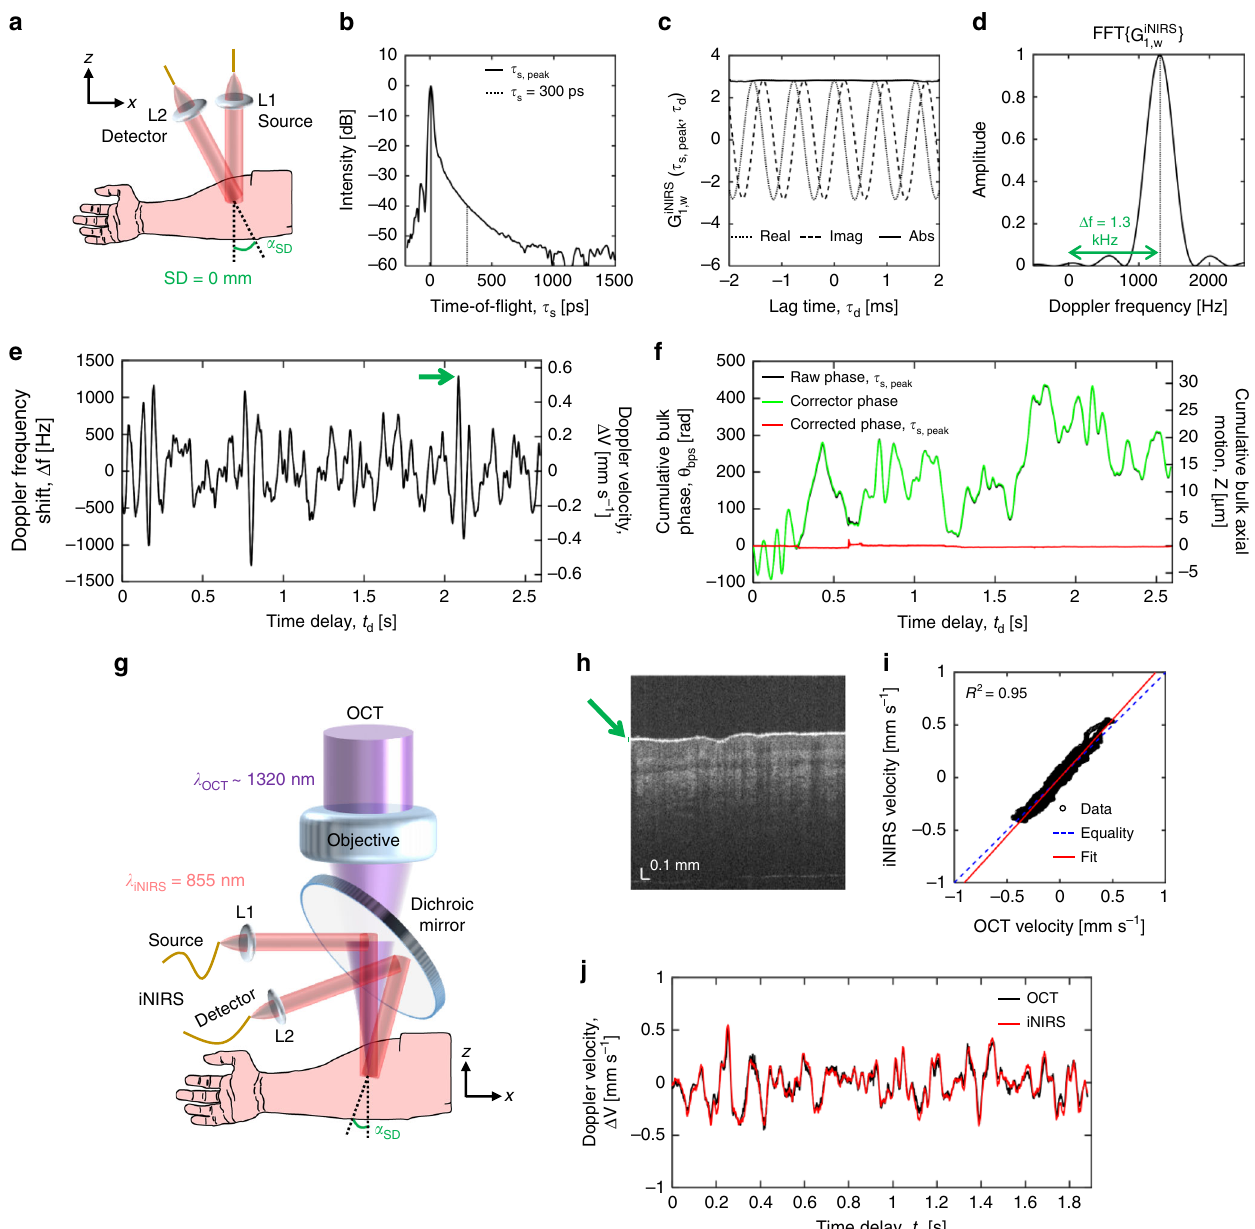
Fig. 2 Correction of sample motion enables fi eld-based diffuse optics. a Geometry for human forearm measurement, where α SD (source – detector angle) is ~10°. For a 2 ms segment at the peak time-of- fl ight (solid black vertical line in b ), the autocorrelation ( c ) rotates with lag time τ d , implying a linear phase shift due to sample motion. d The rate of phase change, i.e. the Doppler frequency shift, can be calculated from the power spectrum (Fourier transform of the autocorrelation G iNIRS ) of the segment. e The Doppler frequency shift time course can also be expressed as a Doppler velocity Δ V assuming α SD = 0°. 1 ; w f Motion correction using the estimated phase (green) virtually eliminates phase drift at the peak TOF, as seen by comparing black and red curves. As shown in Supplementary Fig. 2, phase correction also restores the validity of the modi fi ed Siegert relationship. g – j Simultaneous comparison of bulk phase shifts due to axial motion in iNIRS and optical coherence tomography (OCT). g The two systems are combined with a dichroic beam splitter such that ~1320 nm OCT light is transmitted, while 855 nm iNIRS light is re fl ected. h OCT cross-sectional image from the combined system; Doppler velocity to estimate bulk motion is calculated from the fi rst 50 µ m from the skin surface as shown by the green arrow. The Doppler velocity parametric plot ( i ) and time courses ( j ) show excellent agreement between modalities ( R 2 = estimation of optical properties (Fig. 3e – h). After motion cor- term accounts for static scattering paths (Supplementary Fig. 3) rection, an exponential model (Eq. (7)) consisting of a static and that decorrelate on time scales longer than the fi tting window of dynamic term was fi t to TOF-resolved autocorrelations. This 10 ms used for all data. For the Intralipid re fl ectance measure- model is theoretically well justi fi ed, approaching dynamic light ment, where all particles are dynamic (Fig. 3i), the static com- scattering (DLS) theory (which is valid for a single backscattering ponent is insigni fi cant (blue). For tissue, (Fig. 3j – l), motion angle) and DWS theory (which is valid at early lag times and late correction reveals a strong static component (blue), which likely TOFs) for Brownian motion (Supplementary Note 3). The static describes light scattered only from extravascular tissue. Slopes of